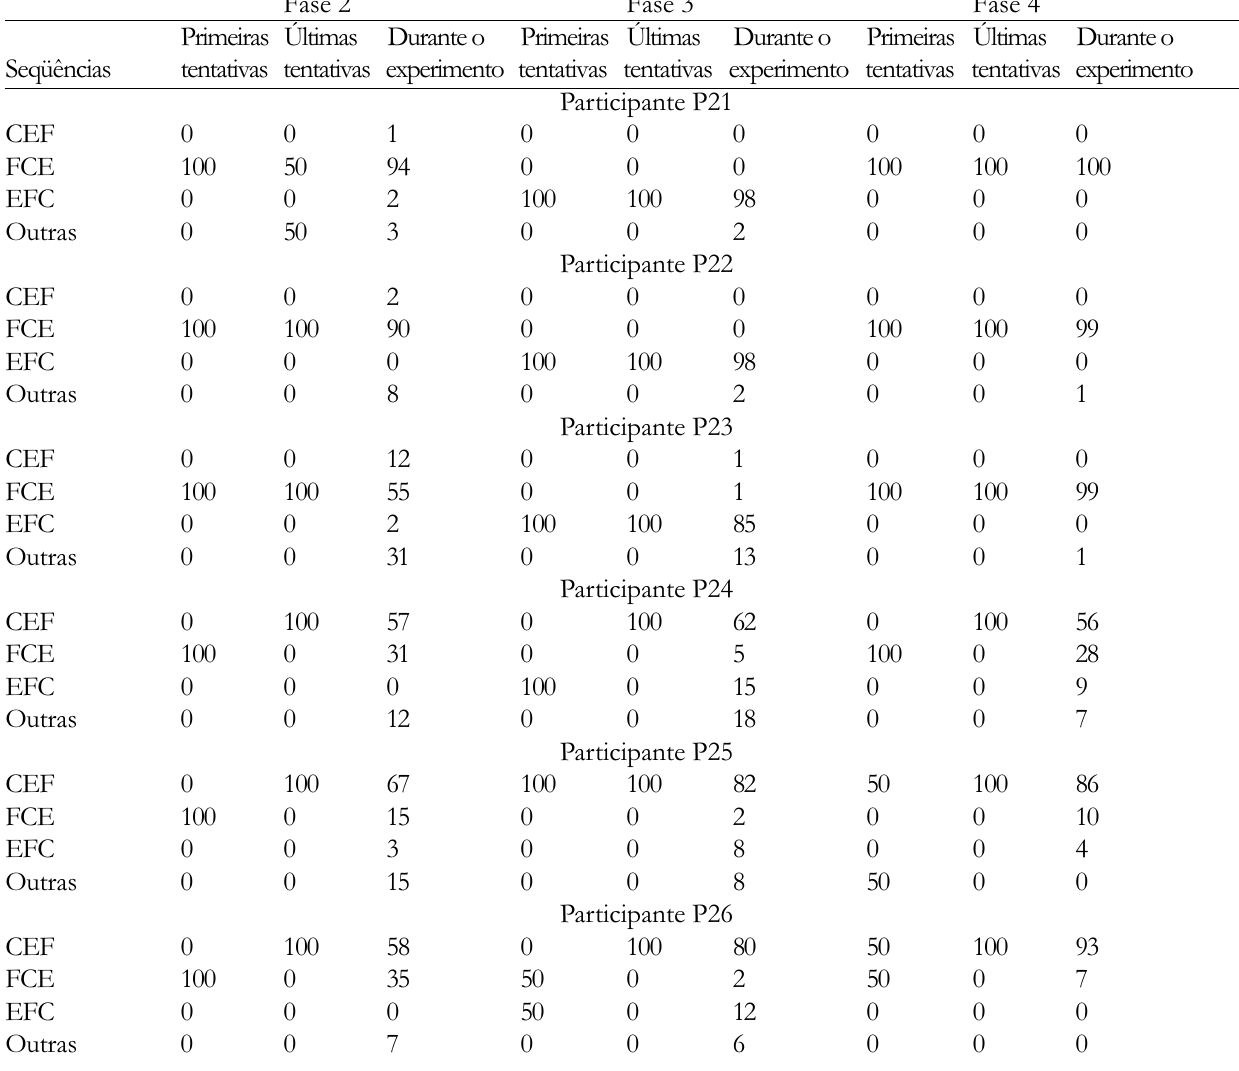
Nota. CEF = Seq(cid:252)Œncia estabelecida por refor(cid:231)o diferencial na Fase 1; FCE = seq(cid:252)Œncia especificada pela